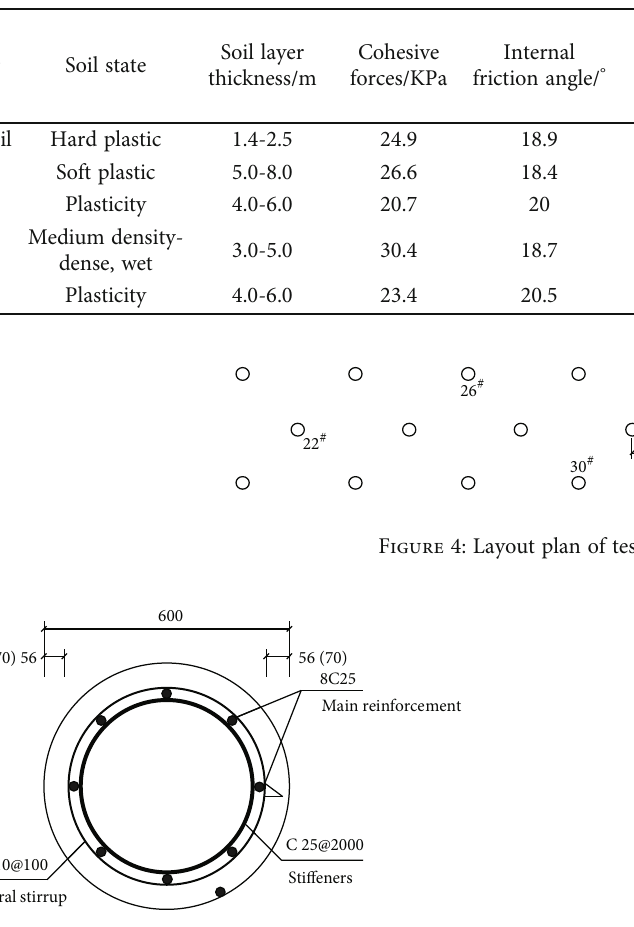
Figure 5: Pile section reinforcement drawing.